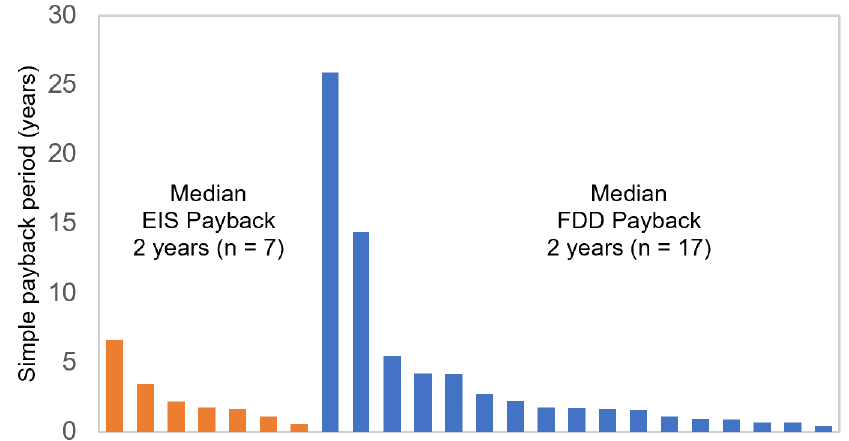
Figure 3. Estimated simple payback period of EIS and FDD ( n = 24, 19 million m 2 [206 million ft 2